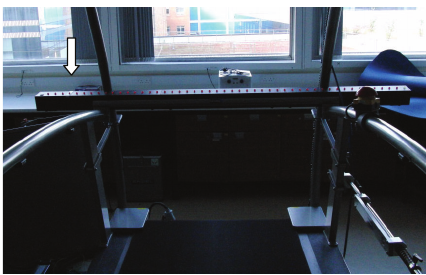
Figure 1: Experimental setup of the Bassin Anticipation Timer. Arrow indicates location of the target light with the motion of the stimulus light moving from right to left.